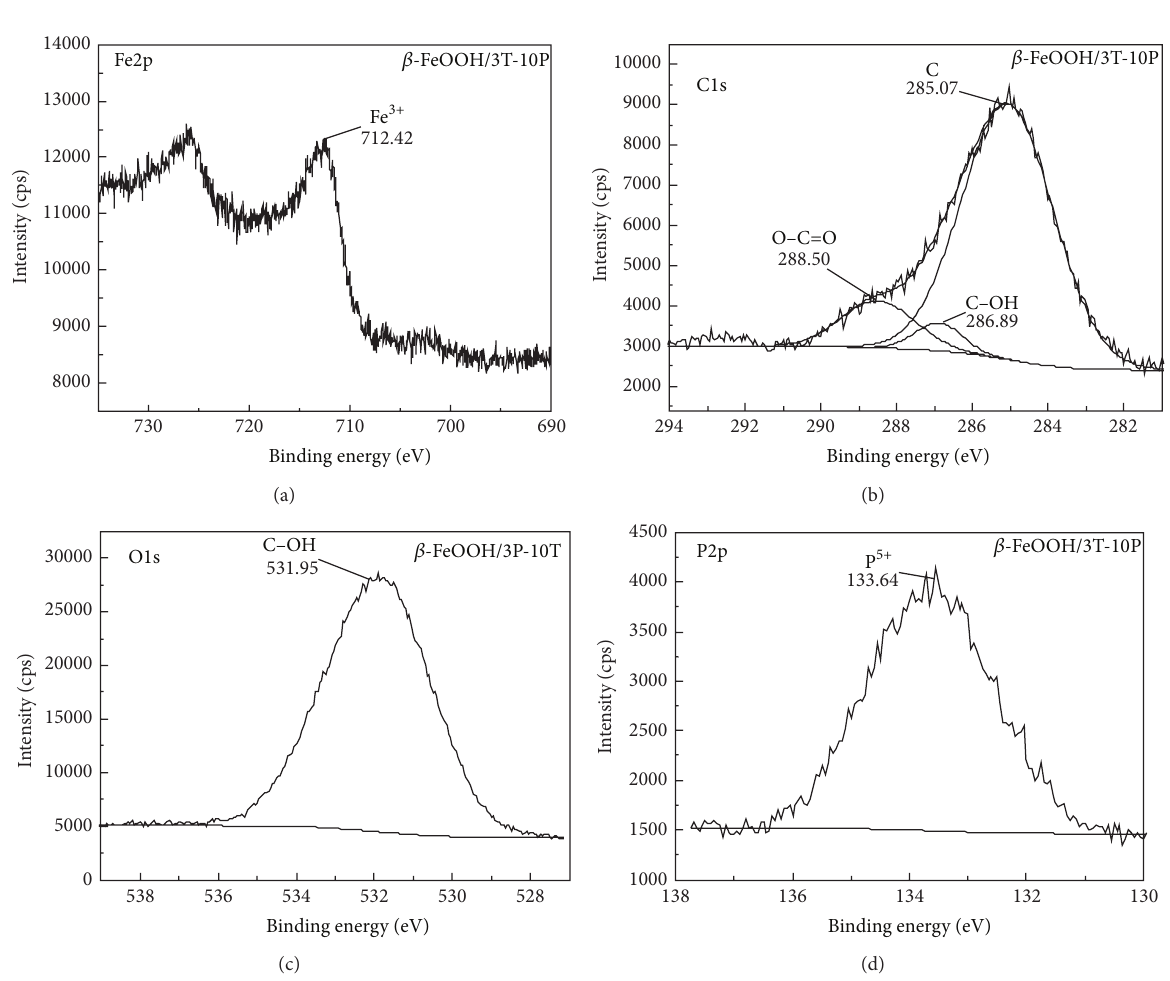
Figure 7: XPS spectra of the products formed from the reaction of 𝛽 -FeOOH and